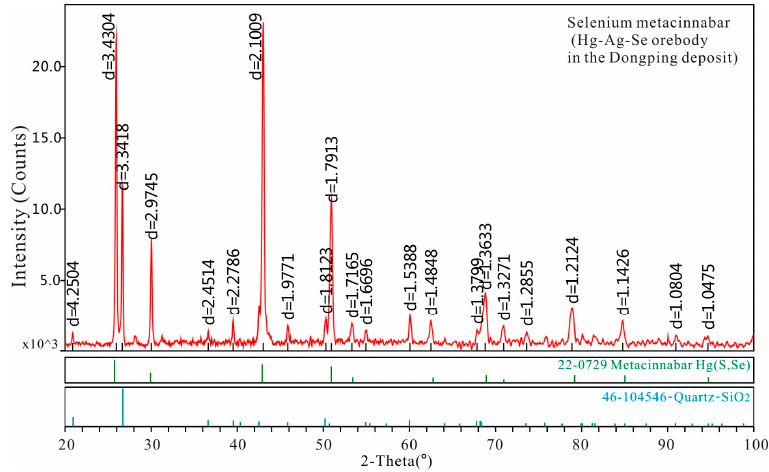
Figure 12. X-ray diffraction pattern of selenium metacinnabar (peak data listed in Table 5) with ICDD reference (No. 22-0729 metacinnabar). Table 5. XRD and crystallographic data for selenium metacinnabar from the Dongping deposit, in comparison with ICDD data.